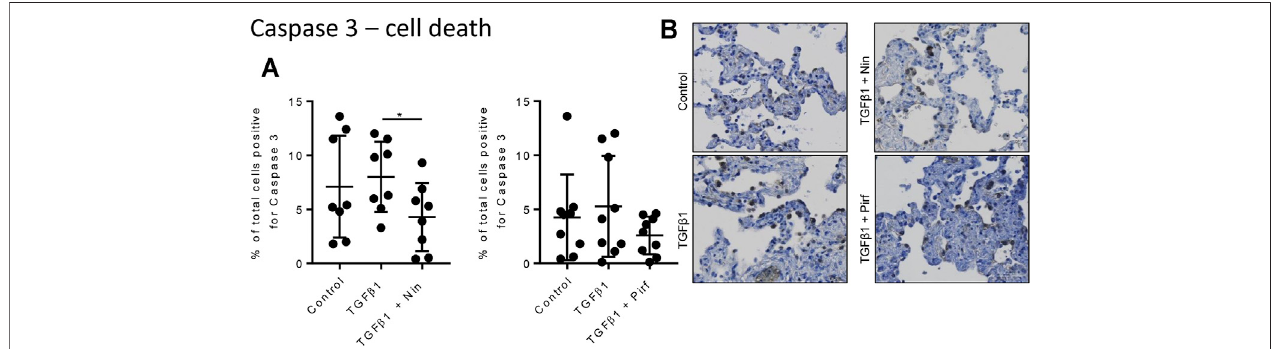
FIGURE 6 | Immunohistological analysis of apoptotic cells assessed by caspase three staining. (A) The percentage cells positive for caspase three in human lung tissue following 7 days incubation with TGF β 1 ± pirfenidone or TGF β 1 ± nintedanib did not change compared to TGF β 1 alone. Nintedanib signi fi cantly reduced the number of caspase three positive cells (* p (cid:1) 0.0021, paired t test). (B) Representative immunohistochemical caspase three staining following 7 days of ex vivo culture. Relevant isotype controls were negative (images not